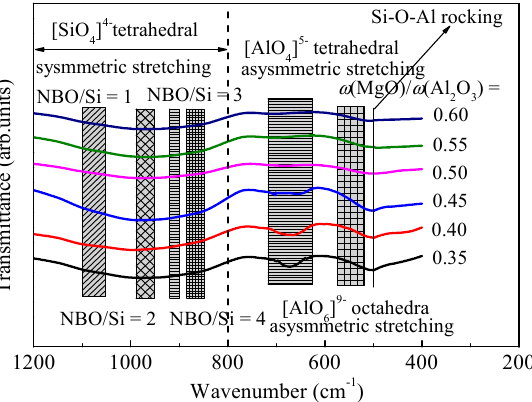
Figure 6. FTIR spectra of smelting slag with the various ω (MgO)/ ω (Al 2 O 3 ) ratios. Figure 7 shows the peak division results of the FTIR with different ω (MgO)/ ω (Al 2 O 3 ) ratios in the wavenumber range of 1200–800 cm − 1 . The peak center position corresponding to each tetrahedral structure increased, and the wavenumber corresponding to the peak center positions of the Q 0 and Q 1 structures (834.7 and 886.8 cm − 1 , respectively) did not change significantly. The peaks corresponding to the Q 2 and Q 3 structures gradually moved to the low wavenumber region, decreasing from 985.0 to 970.3 cm − 1 and from 1047.2 to 1030.6 cm − 1 , respectively. This shows that the stability of the Q 2 and Q 3 structural units in the slag structure decreased with the increase of the ω (MgO)/ ω (Al 2 O 3 ) ratio and tended to simplify in structure.